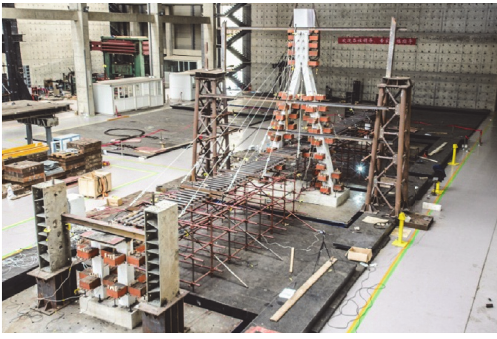
Figure 5: Assembled bridge